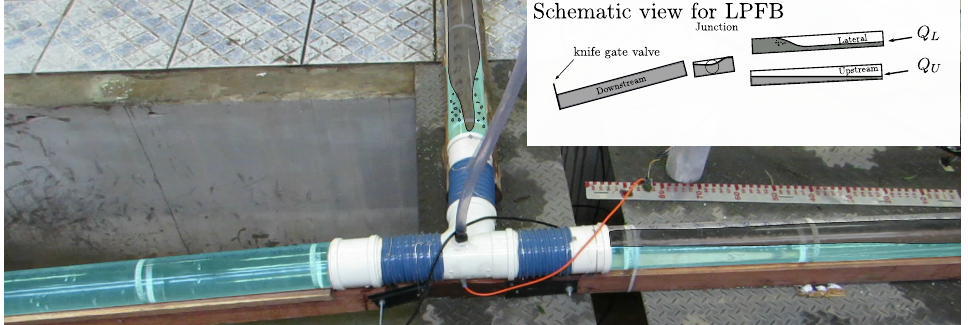
Figure 6. Visualization at some seconds after the knife gate closure showing the pressurization process for